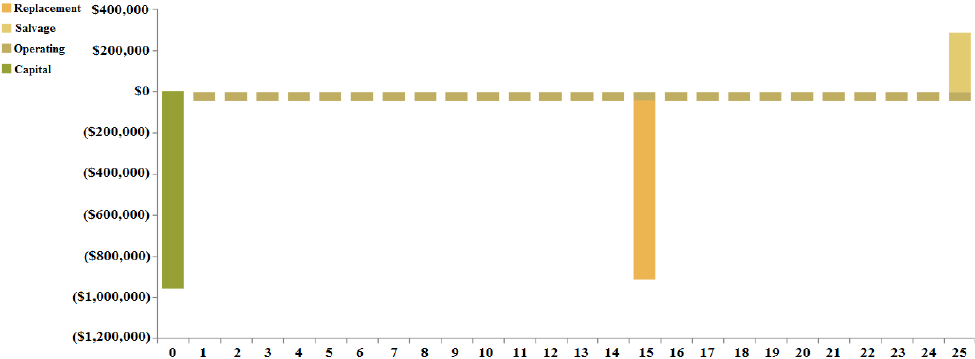
20 of 30 Figure 20. Electrical energy generation on a monthly basis for case III (Ba/H/S). The maximum component cost for case III is that incurred by the battery of USD 1,695,001.23 and the lowest component cost that is incurred by the solar-PV converter of USD 56,045.35. The total component cost breakdown for case III is shown in Figure 21. A cash-flow study for case III is shown in Figure 22. The overall replacement and capital prices for the total system are computed as USD 498,525.63 and USD 958,940, respec- tively.